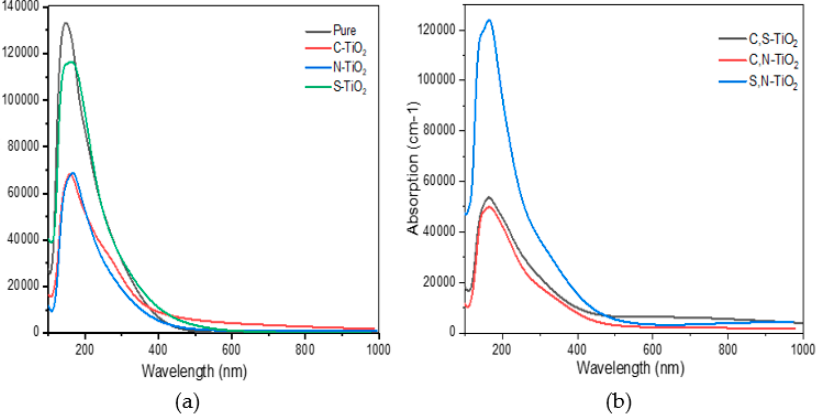
Figure 6. Optical absorption curves of the ( a ) (C, N and S) mono doped and ( b ) (C-S, C-N and N-S) (210) doped brookite surface.